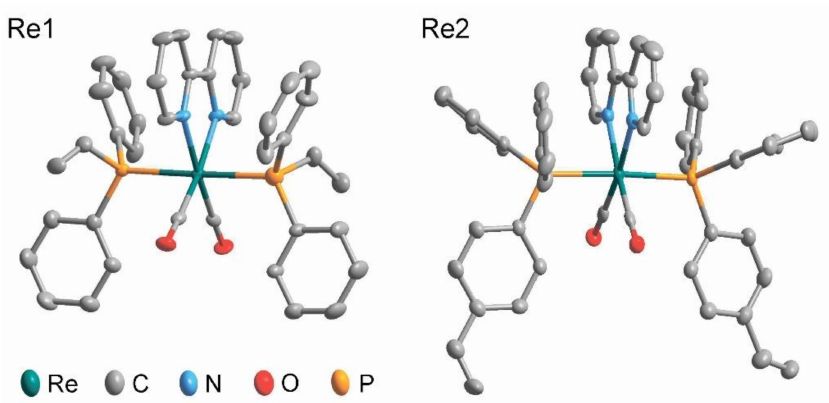
Figure 1. Molecular view of complexes Re1 and Re2 . The thermal ellipsoids are shown at the 40% probability level. Hydrogen atoms and counter ions have been omitted for